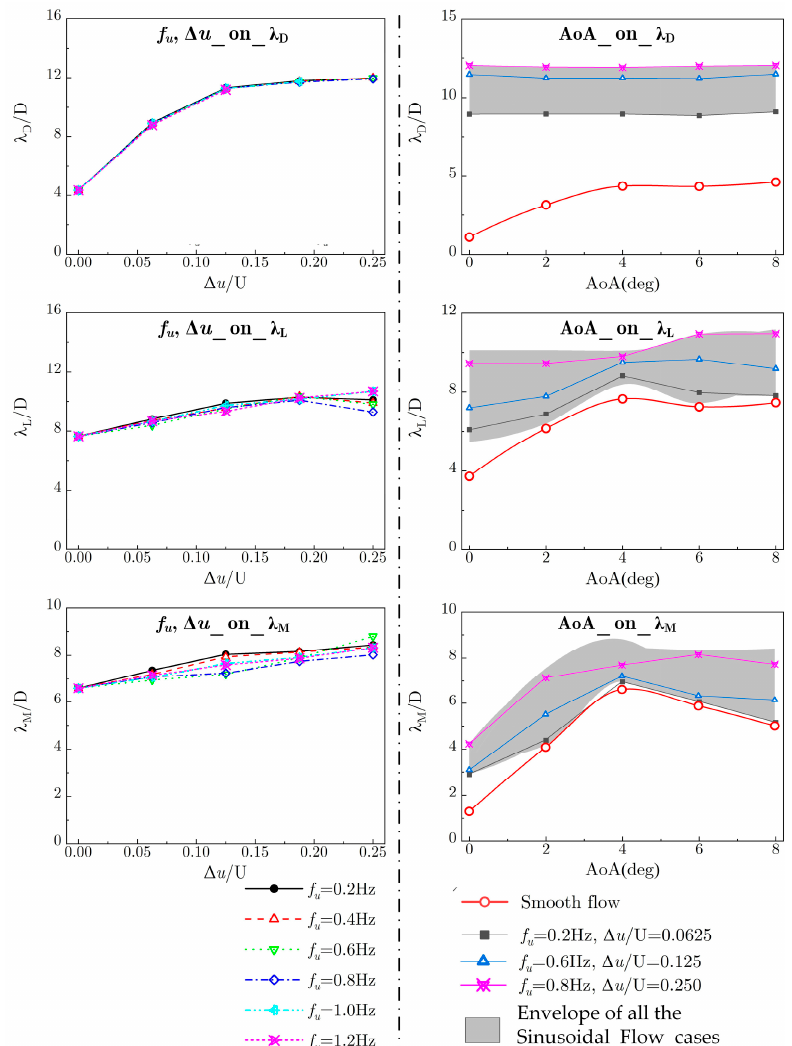
Figure 13. Spanwise correlation lengths of C D , C L , and C M . The effects of f u and ∆ u /U (at AoA = 4 ◦ ) are shown in the left column; the effects of AoA are shown in the right column.